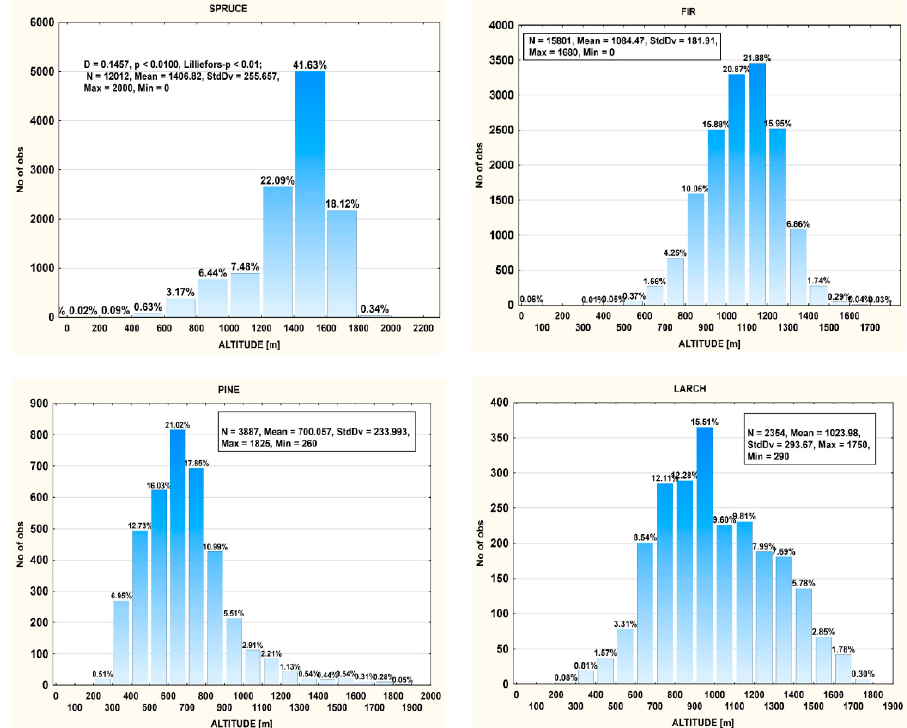
Figure 2. Distribution of stand elements based on altitude for resinous species located in Southern Carpathians.